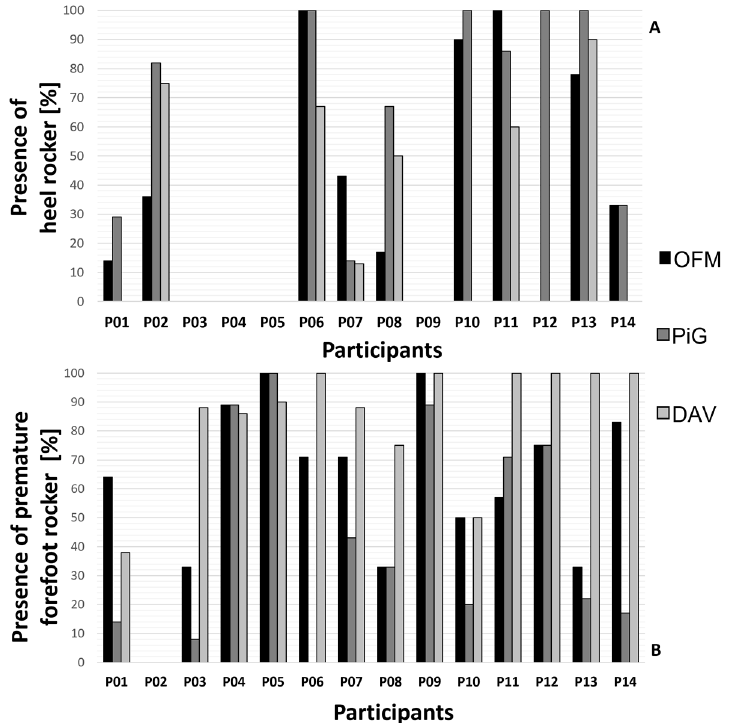
Figure 3. Graphical representation of the percentage of the gait cycles in which: ( A ) a heel rocker (up) and ( B ) a premature forefoot rocker (down) were detected using OFM (black boxes), PiG (dark gray boxes), and DAV (light gray boxes) for each participant.